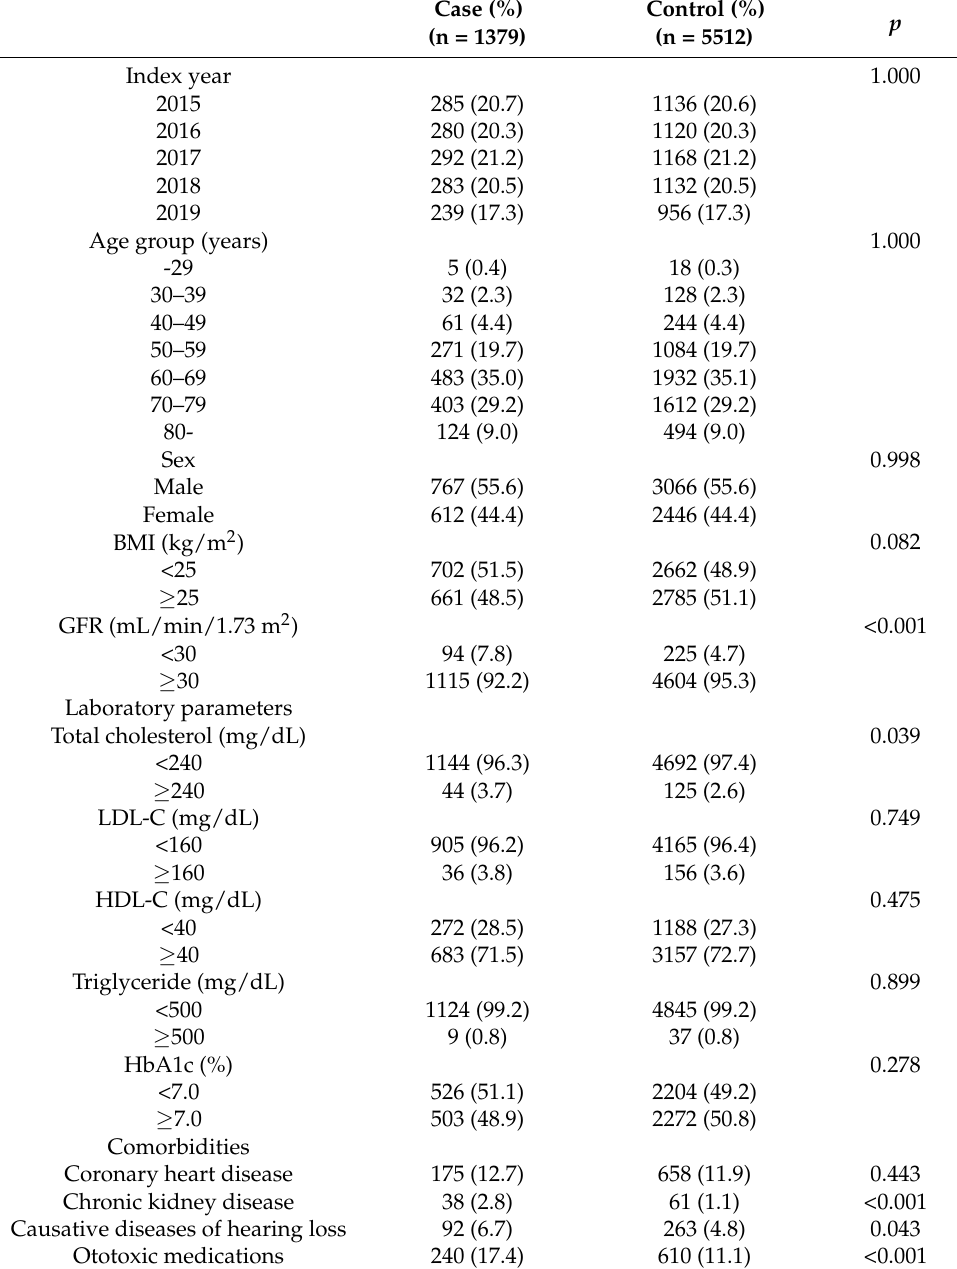
Table 1. Baseline characteristics of study population for sensorineural hearing loss or